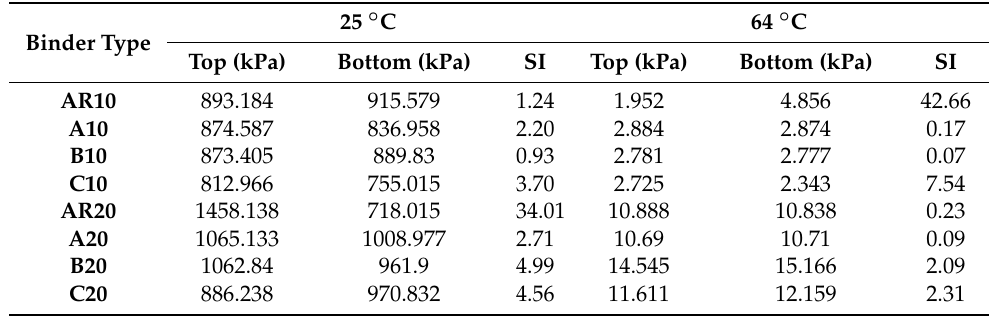
Table 7. Complex shear modulus and separation index of different asphalt binders at low and high temperatures.